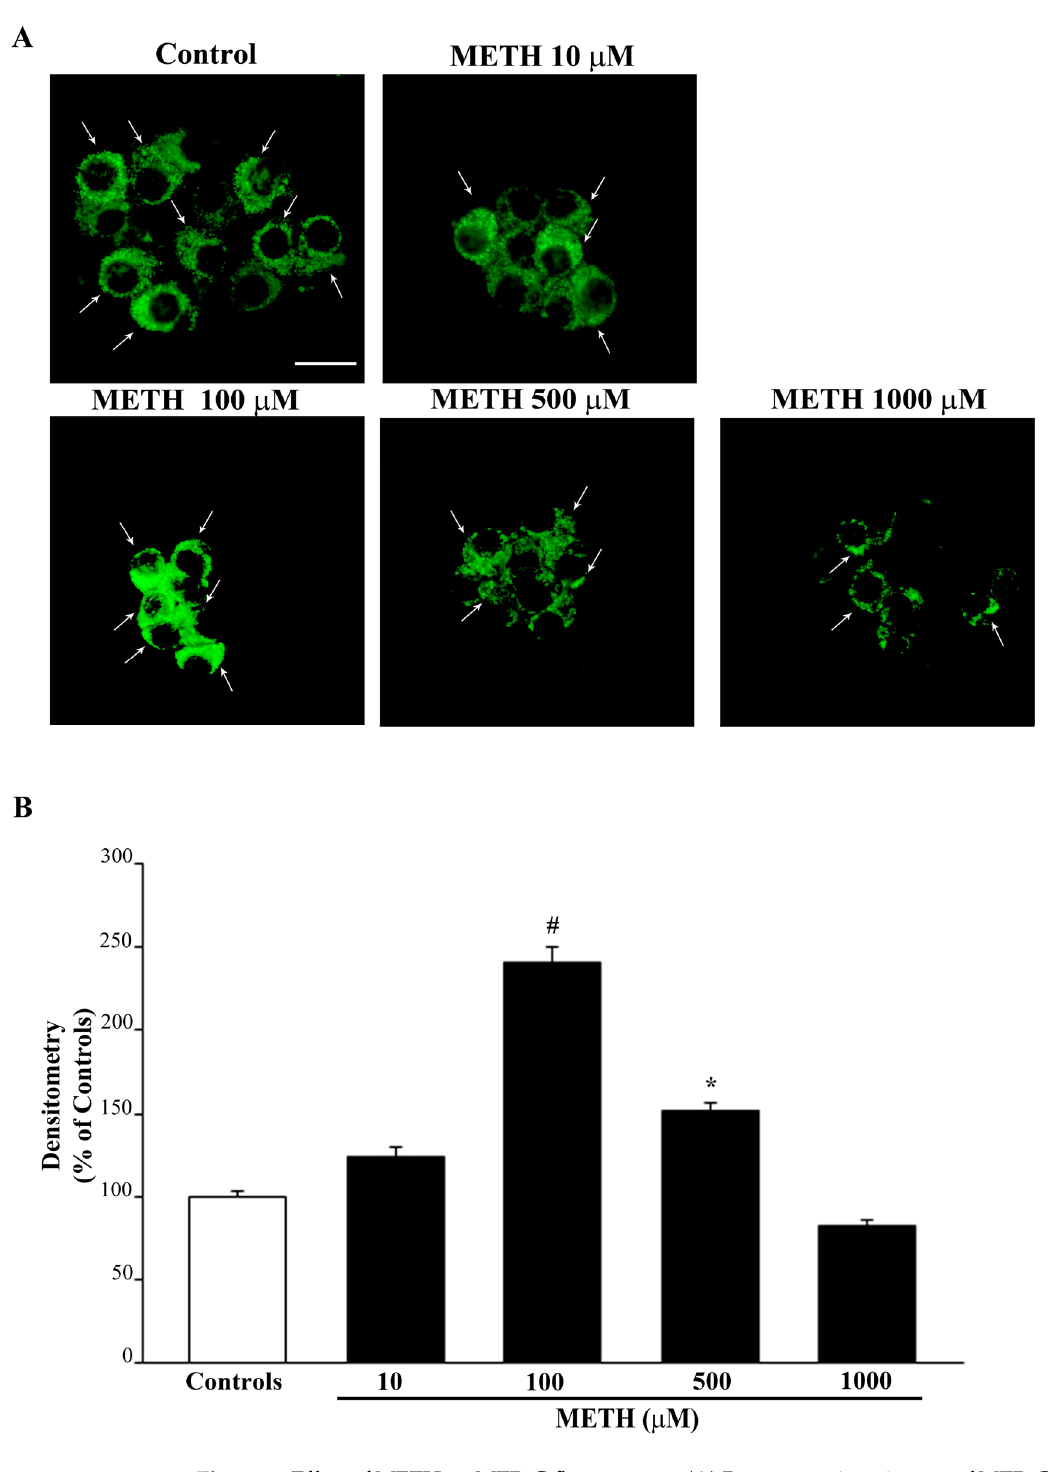
Figure 3. Effect of METH on MTR-G fluorescence. ( A ) Representative pictures of MTR-G fluorescence, which labels total (both healthy and altered) mitochondria, show that MTR-G-positive mitochondria increase at the dose of METH 100 μ M, whereas they are similar to controls following higher METH doses (i.e., 1000 μ M). Arrows indicate intensely MTR-G-stained cells. This is confirmed by the graph ( B ), which reports the densitometry of MTR-G fluorescence. Values are given as the mean percentage ± S.E.M. of optical density (assuming controls as 100%) from three independent experiments. * p < 0.05 compared with controls; # p < 0.05 compared with all other groups. Scale bar = 11 μ m.